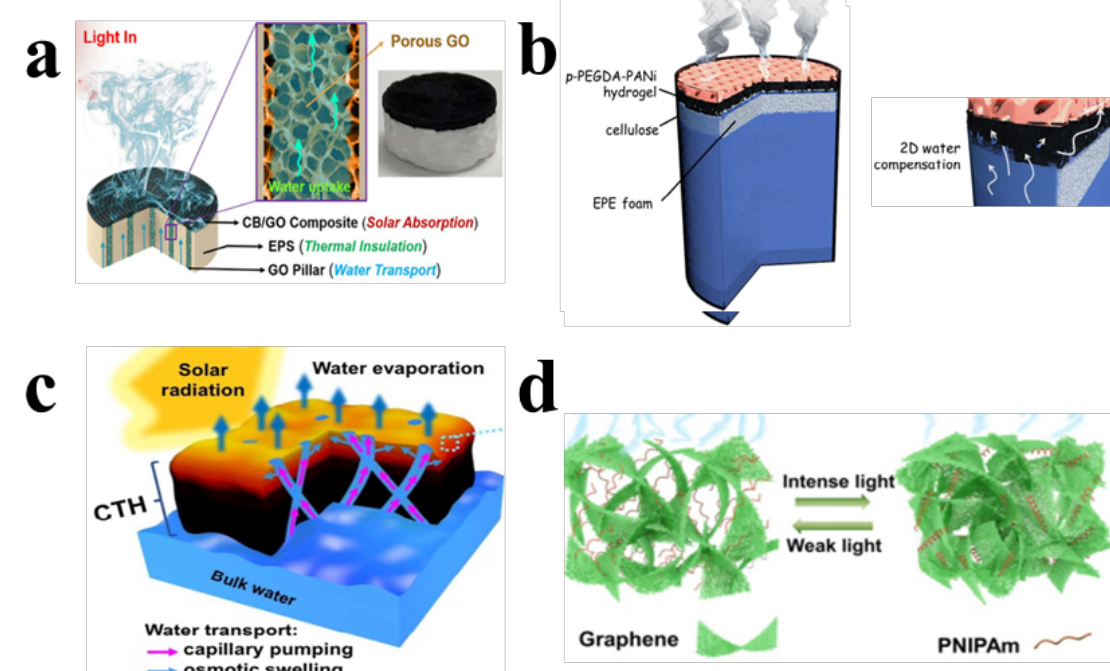
Figure 11: Schematic illustration of: (a) 1D water transport channels [78]; (b) 2D water transport channels [43]; (c) 3D water transport chan- nels [42]; (d) self-regulating water transport channels